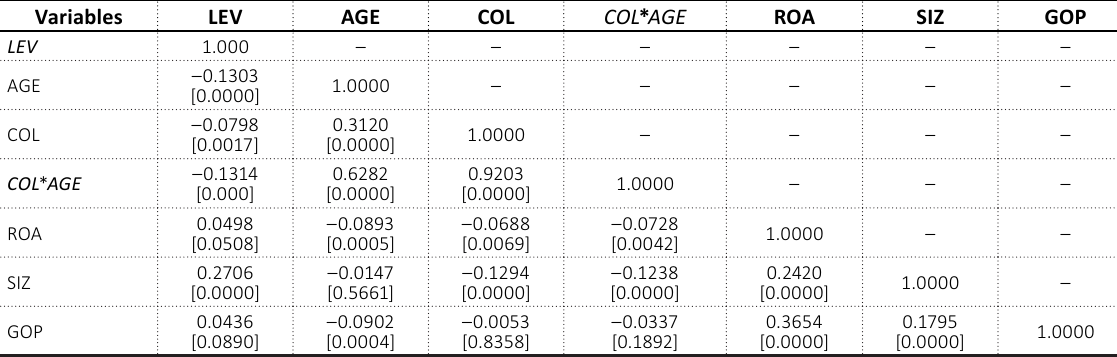
Table 4. Analysis of total sample